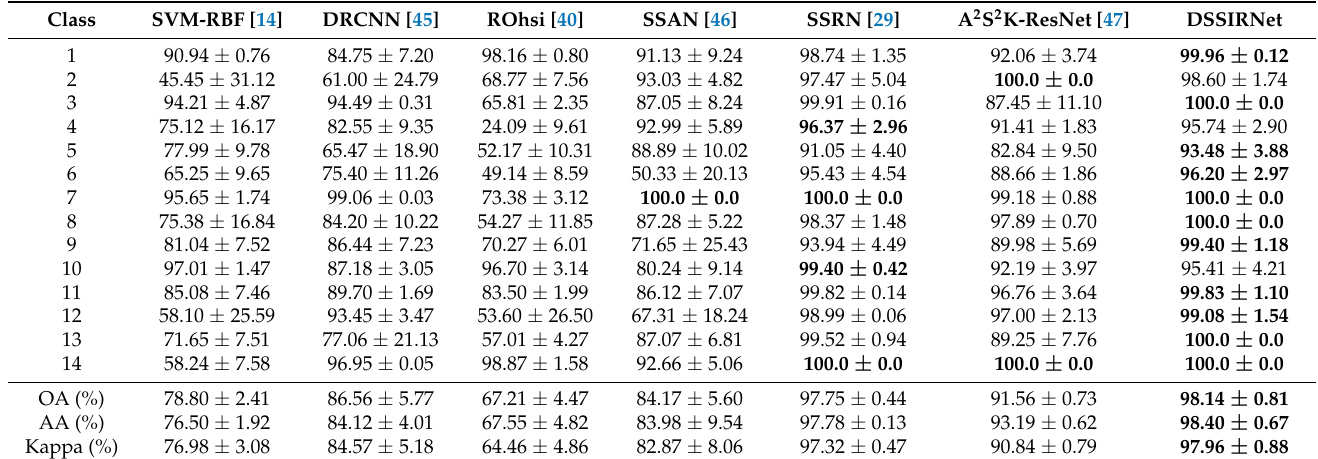
Table 6. Classification results of different methods on the BS